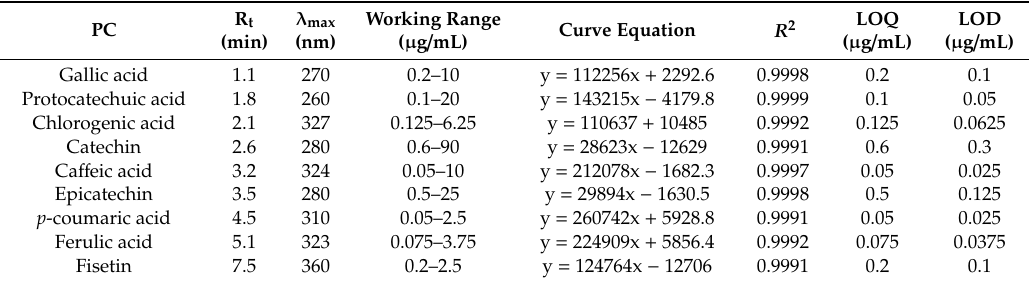
Table 2. Calibration curves for 9